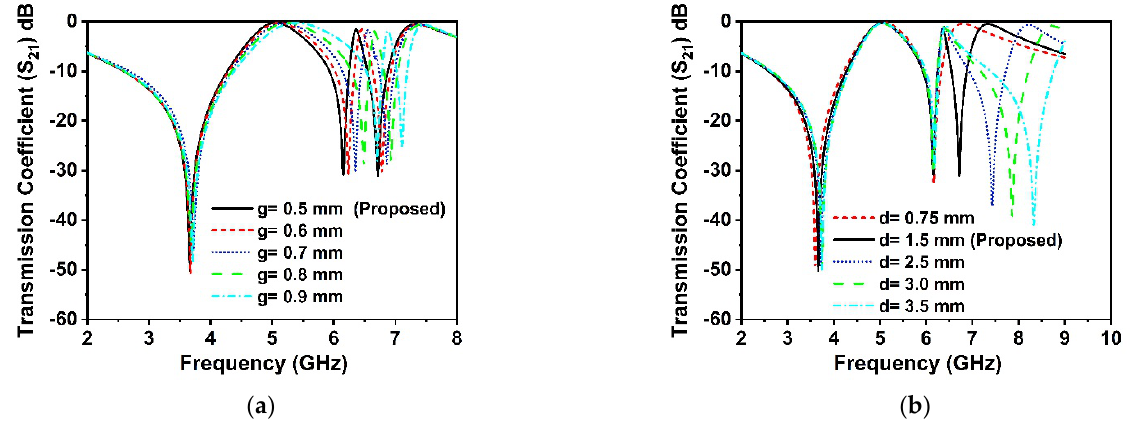
Figure 11. Analysis of transmission coefficients with distinct ( a ) split gap ‘g’ and ( b ) middle connecting strip ‘d’.